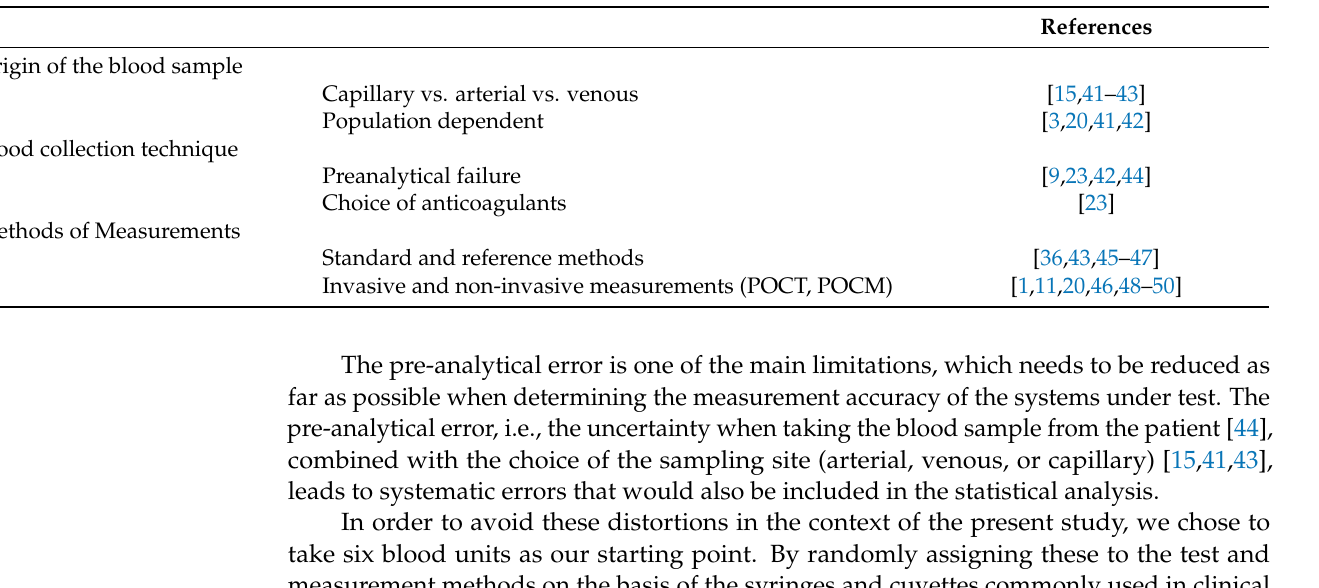
Table 5. List of causes for the variability in tHb